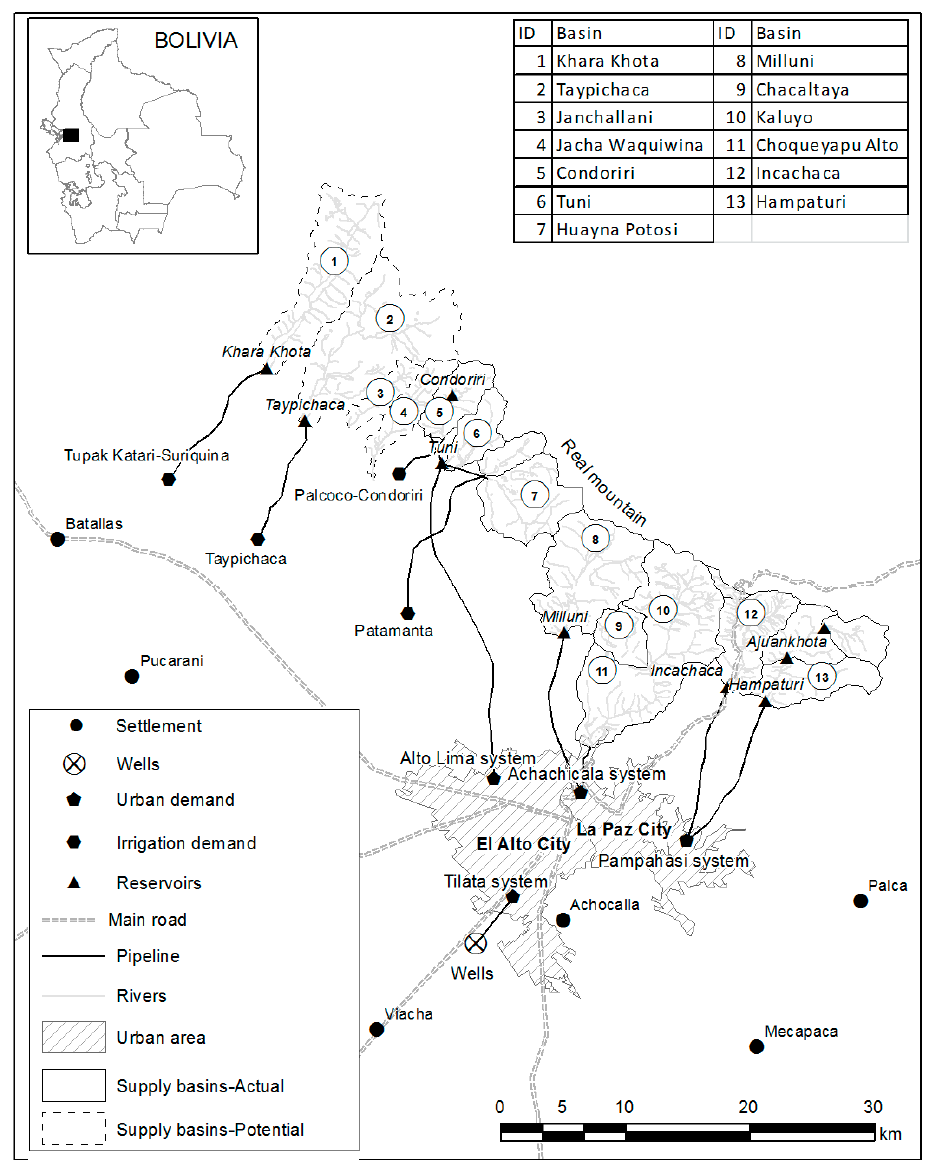
Figure 4. The La Paz/El Alto Region of Bolivia depicting current sources of water supply for La Paz and El Alto (solid outlines), along with potential new source watersheds (dashed outlines), existing reservoirs (triangles), conveyance facilities (solid lines), and points of urban (hexagons) and agricultural (pentagons) demand. The wellfield (circular cross hatch) providing water to El Alto is also shown. (Data source: Ministry of Environment and Water).